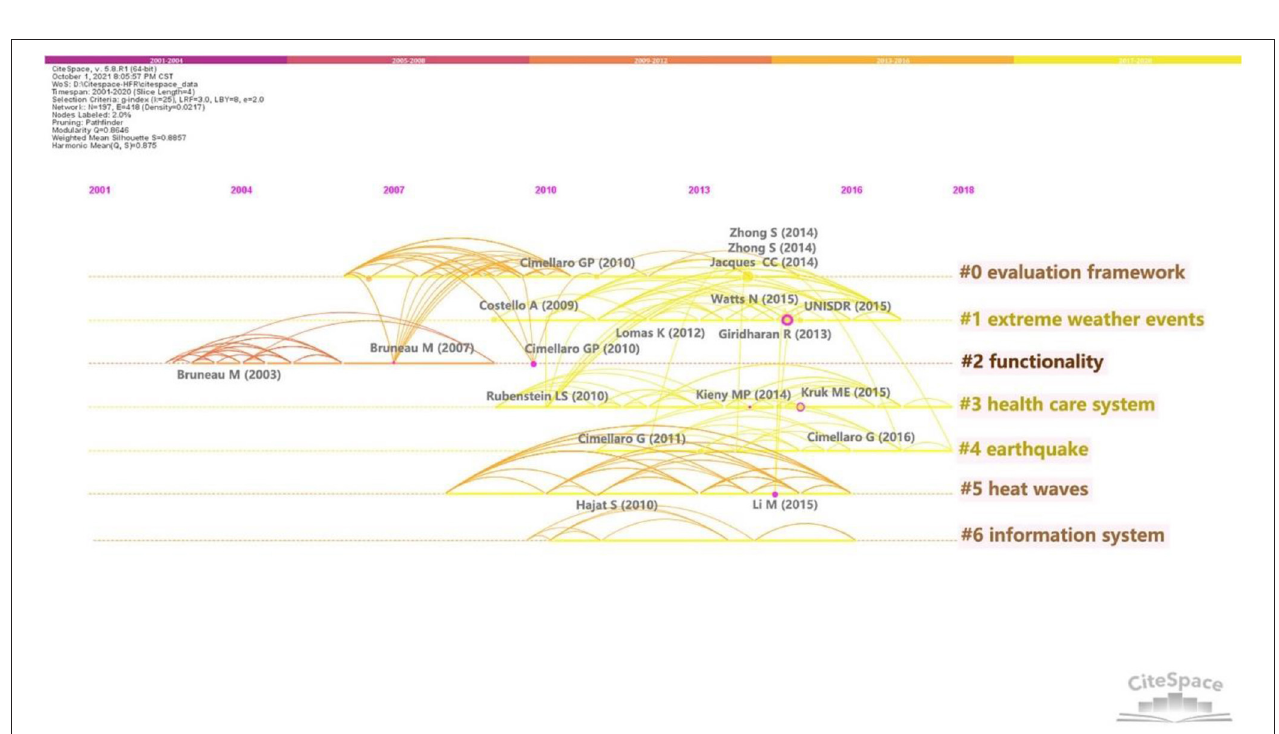
FIGURE 7 | Timeline view of co-citation